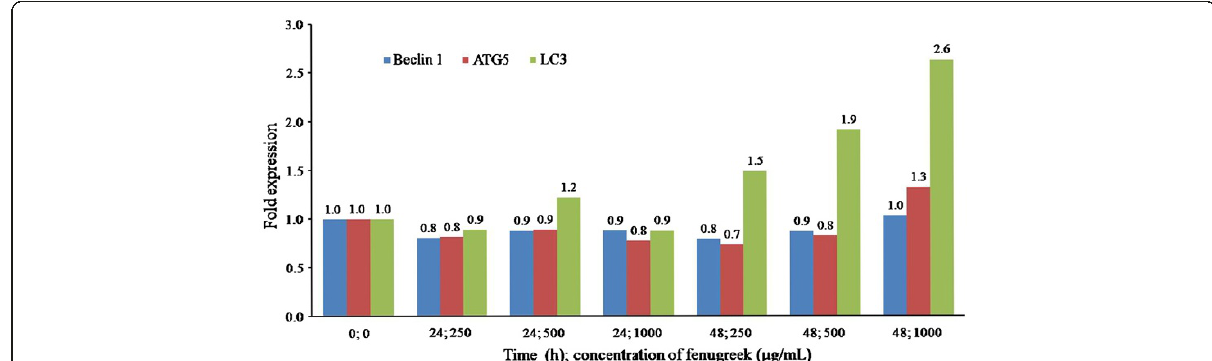
Figure 5 Transcriptional regulation of autophagic genes by fenugreek. Jurkat cells incubated with 250, 500 and 1000 μ g/mL of fenugreek extract were quantitatively analyzed for transcripts of autophagic pathway genes beclin 1, ATG5 and LC3 by RT-PCR using β -actin as internal reference. Dose dependent increase in LC3 transcripts was found in cells incubated for 48 hr while no significant changes were observed for beclin 1 and ATG5.